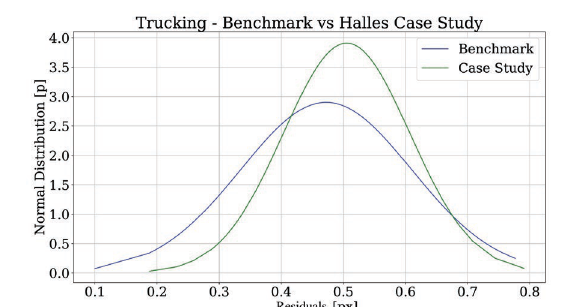
Figure 11. Trends of residual values for Les Halles compared with the trucking benchmark.